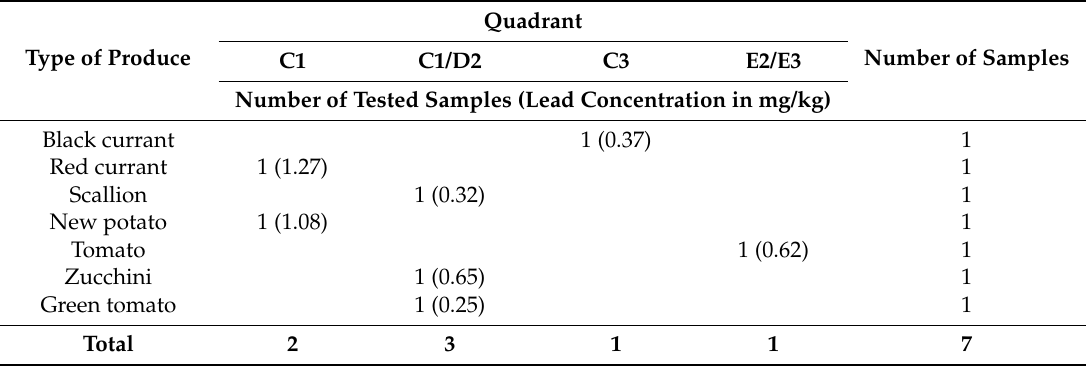
Table 4. Types of produce and number of samples in which lead concentrations exceeded threshold values in village Baroševac during